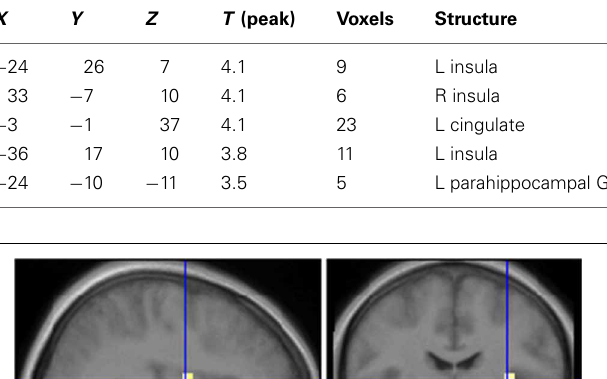
FIGURE 4 | Comparison of an ambroxan containing mixture with a mixture which does not contain ambroxan in subjects who perceive ambroxan (left) and subjects who do not perceive ambroxan (right). Area in cross hairs: right cingulate. Contrast left: SEN[MIX + AMB] vs. SEN[MIX] masked with [AMB + MIX + AMB + MIX] vs. CON; y = − 28; Contrast right: INS[MIX + AMB] vs. INS[MIX] masked with [AMB + MIX + AMB + MIX] vs. CON; y = − 13.